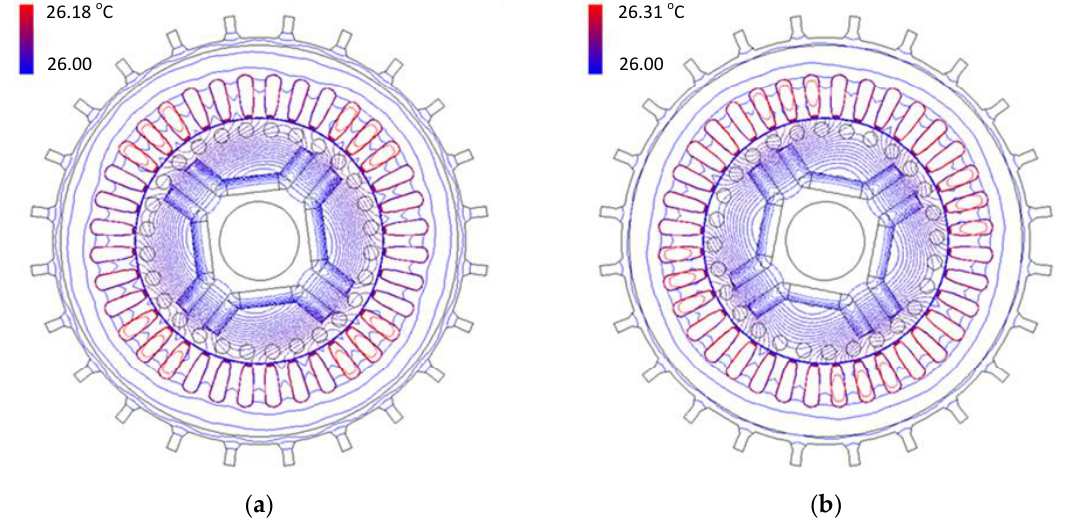
Figure 11. Temperature distribution in an electromechanical steady-state after start-up for t = 0.6 s, τ i = 26°C, J i = 0.0082 kgm 2 : ( a ) T L = 0 Nm, ( b ) T L = 19.5 Nm.